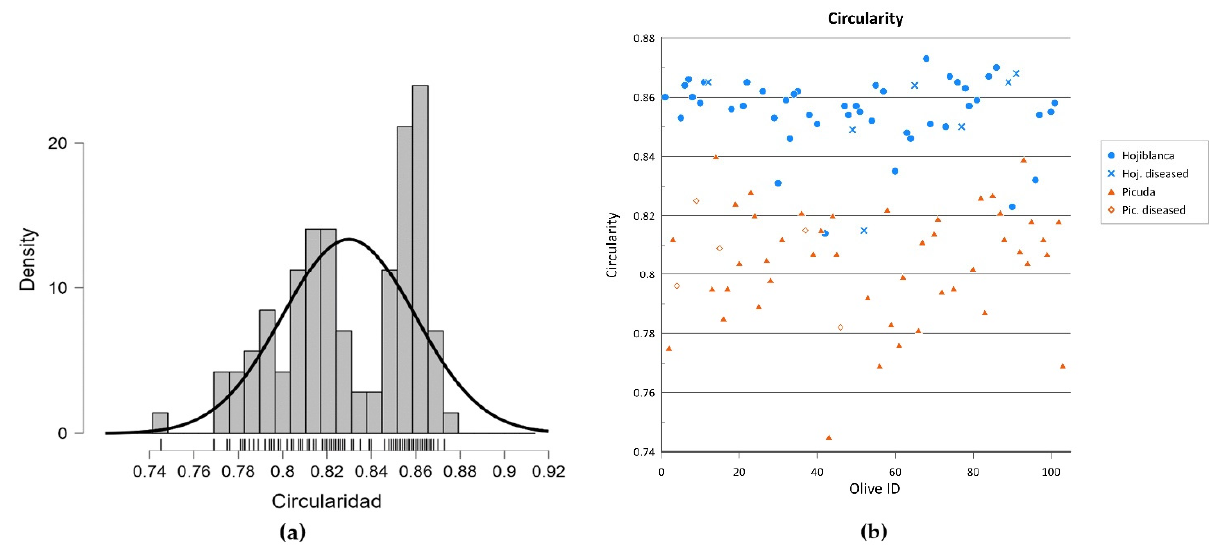
Figure 15. Circularity distribution: ( a ) histogram vs. theoretical probability density function (PDF), ( b ) scatter plot.